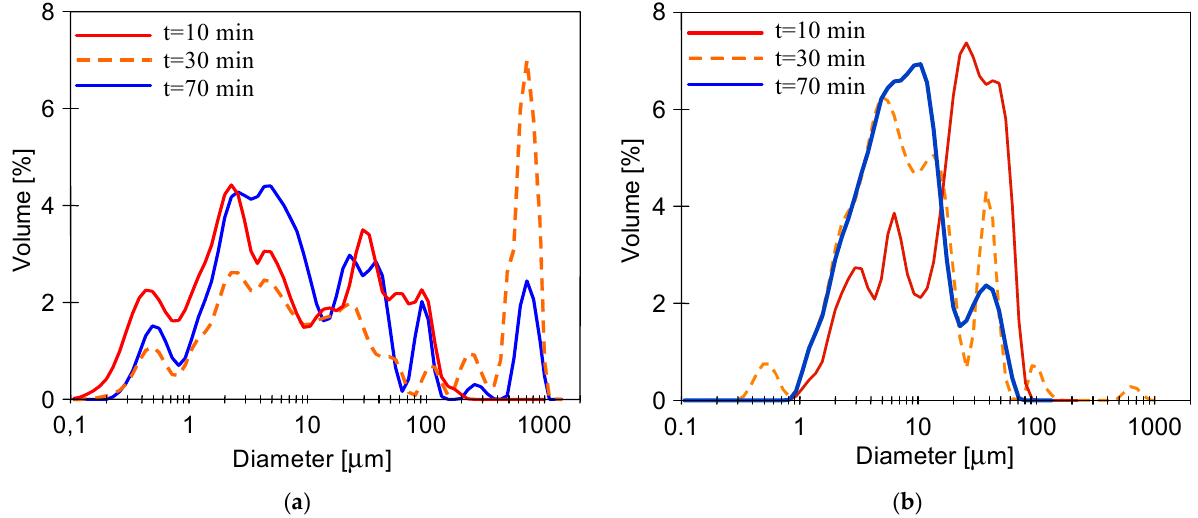
Figure 8. Changes in the droplet size distribution of the model emulsions during the MF process: ( a ) C F = 50 mg/L; ( b ) C F = 150 mg/L.